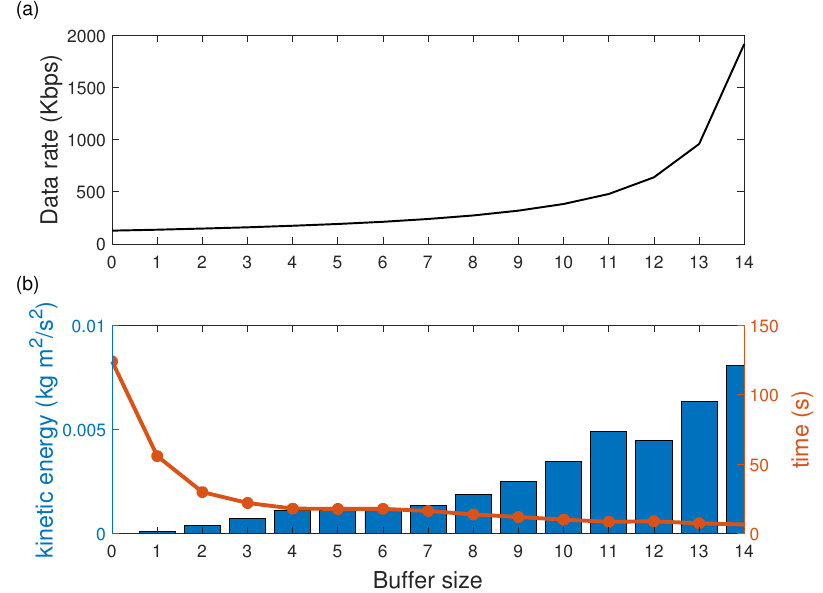
Figure 13. Buffer size vs. ( a ) consumption data rate and ( b ) kinetic energy and execution time comparison as a system’s performance